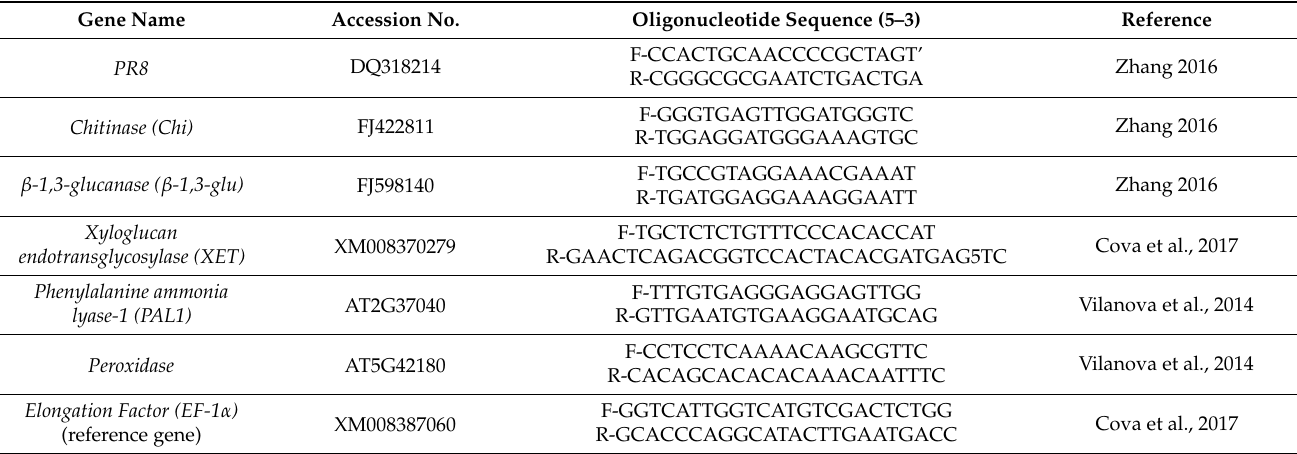
Table 1. Name and sequence of primer pairs used for quantitative real-time polymerase chain reaction (qRT-PCR) analysis. Gene Name